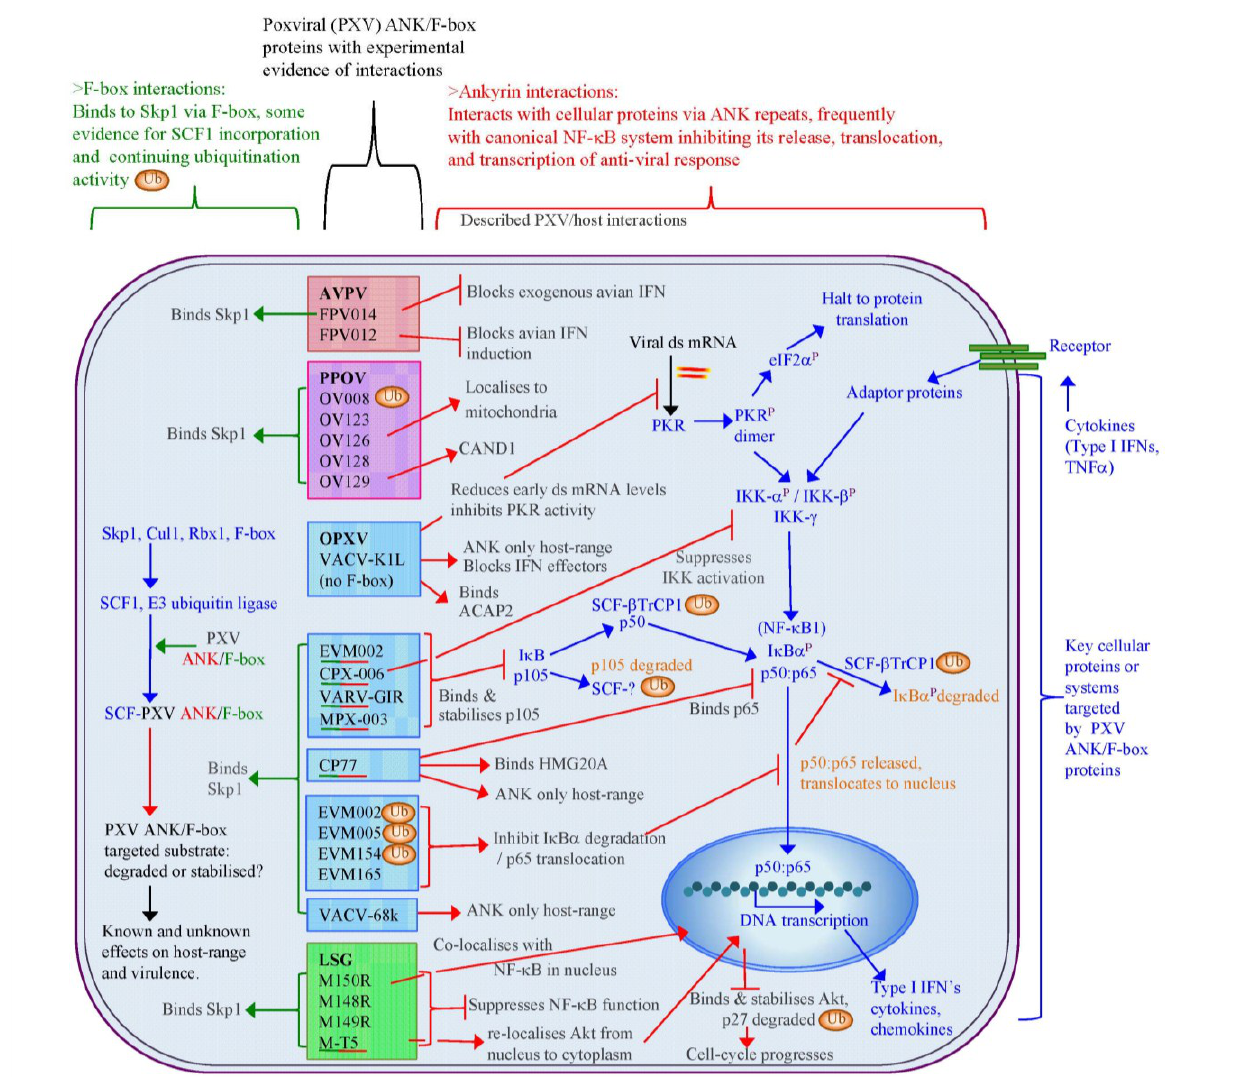
Figure 4. Interactions of ANK/F-box proteins are known from several poxviral species of the Avipoxviru s (AVPV) [117,122], Parapoxvirus (PPOV) [78], Orthopoxvirus (OPXV) genera [79–83,106,109,115,116], and also the Leporipoxvirus super-group (LSG) genera [84,101,123]. These poxviral proteins bind to Skp1 via F-box domains, and in some cases also interact with other cellular proteins or have an effect on other cellular systems, most frequently the canonical activation of NF-κB1 transcriptional regulation. Green/red underlined poxviral (PXV) proteins indicate demonstrated binding of both Skp1 and a cellular substrate. Ubiquitination (Ub) with SCF1 ligases containing a poxviral ANK/F-box has been shown in several examples: OV008, EVM002, EVM005, and EVM154; E3 ubiquitin ligases also control key parts of the NF-κB signalling via SCF-βTrCP1 and an unknown SCF that target p105 and IκBα for proteasomal degradation and